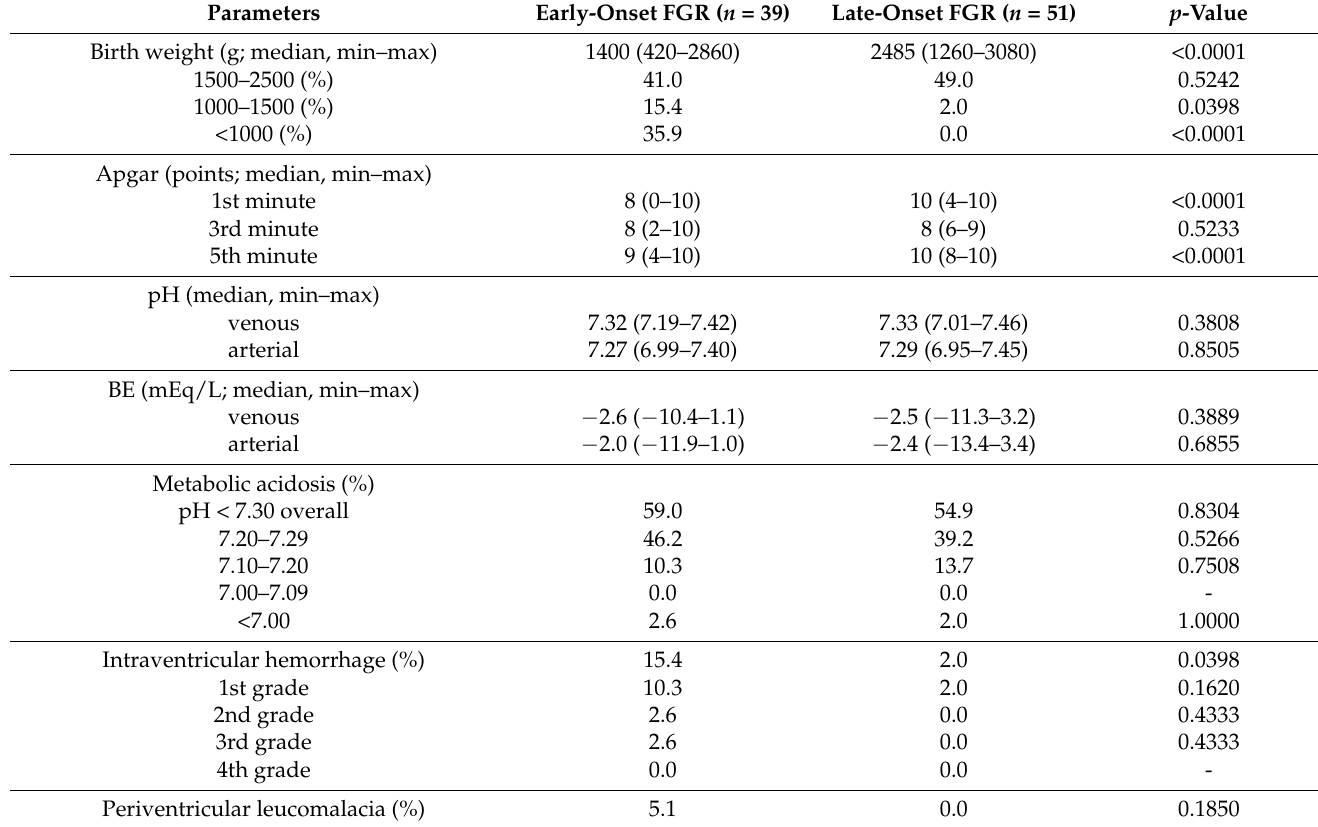
Table 6. Perinatal outcomes in the early-onset and late-onset FGR